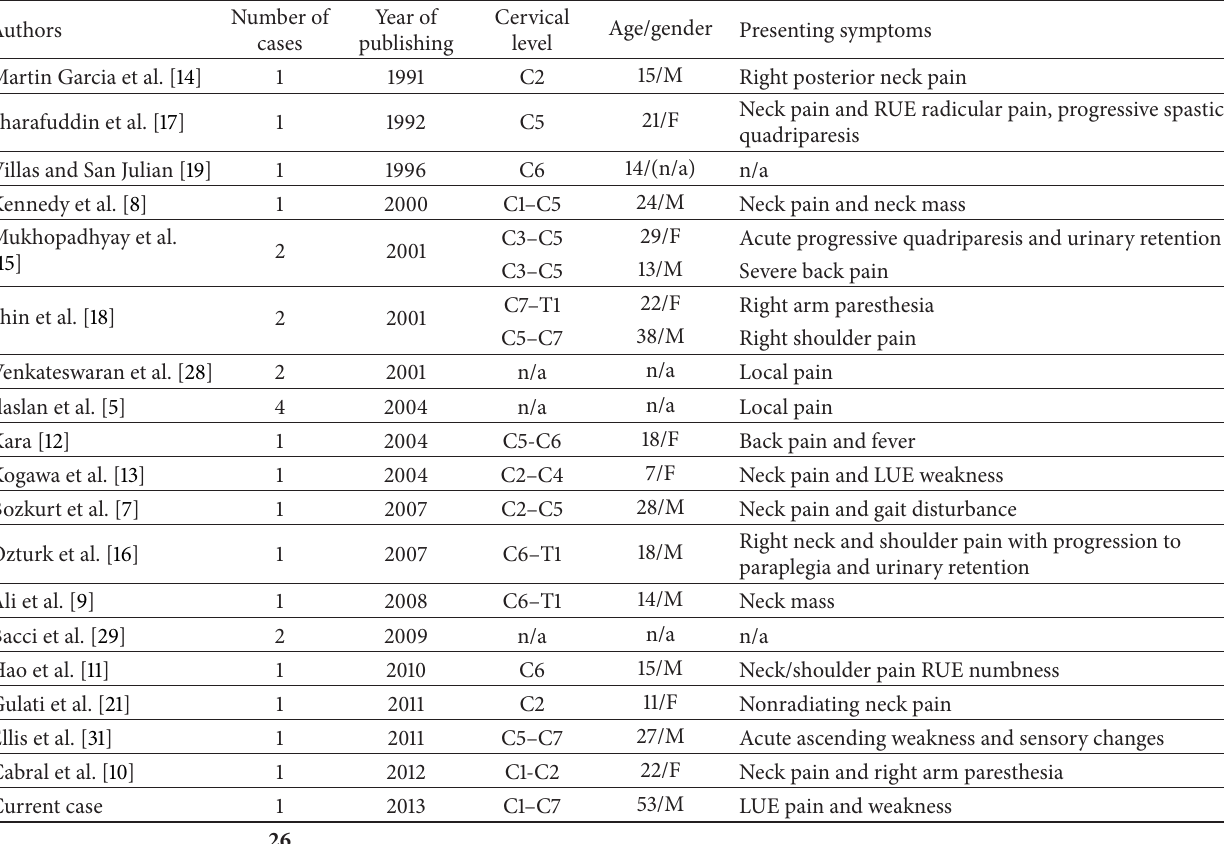
Table 1: Summary review: primary EES of cervical spine (available in